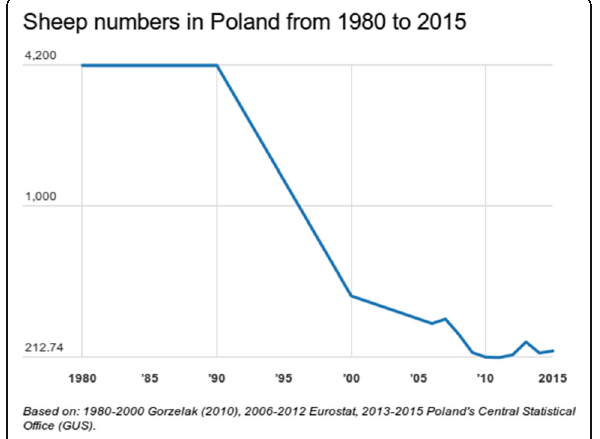
Figure 2 Sheep numbers in Poland from 1980 to